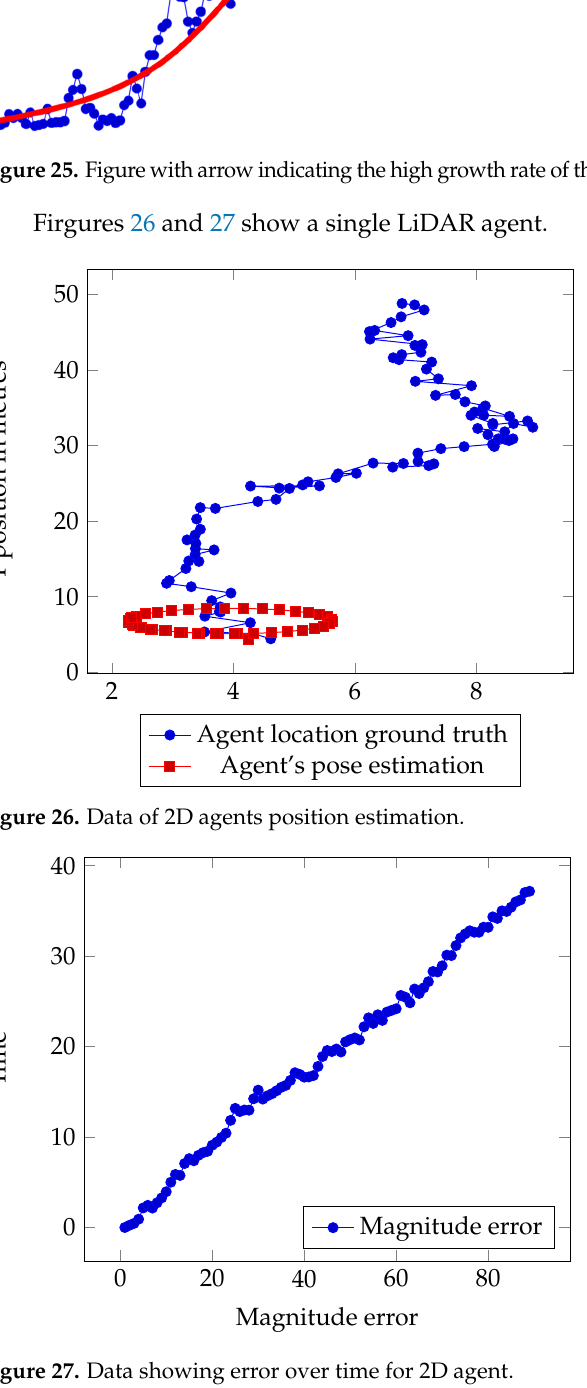
Figure 27. Data showing error over time for 2D agent. Figure 28 and 29 is the final set with the combined